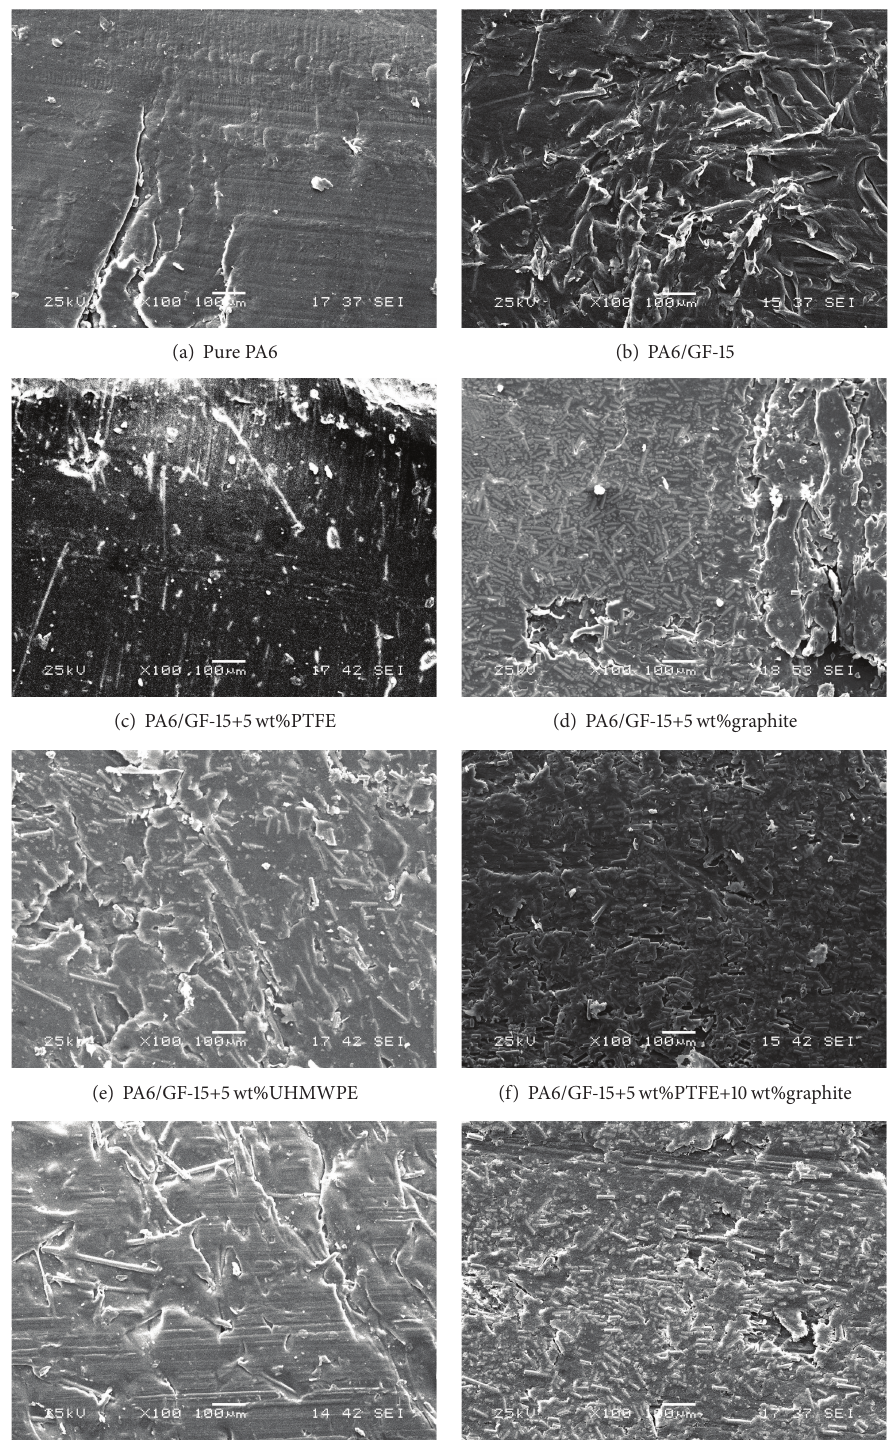
Figure 5: SEM images of worn surface of PA6 composites filled with different solid